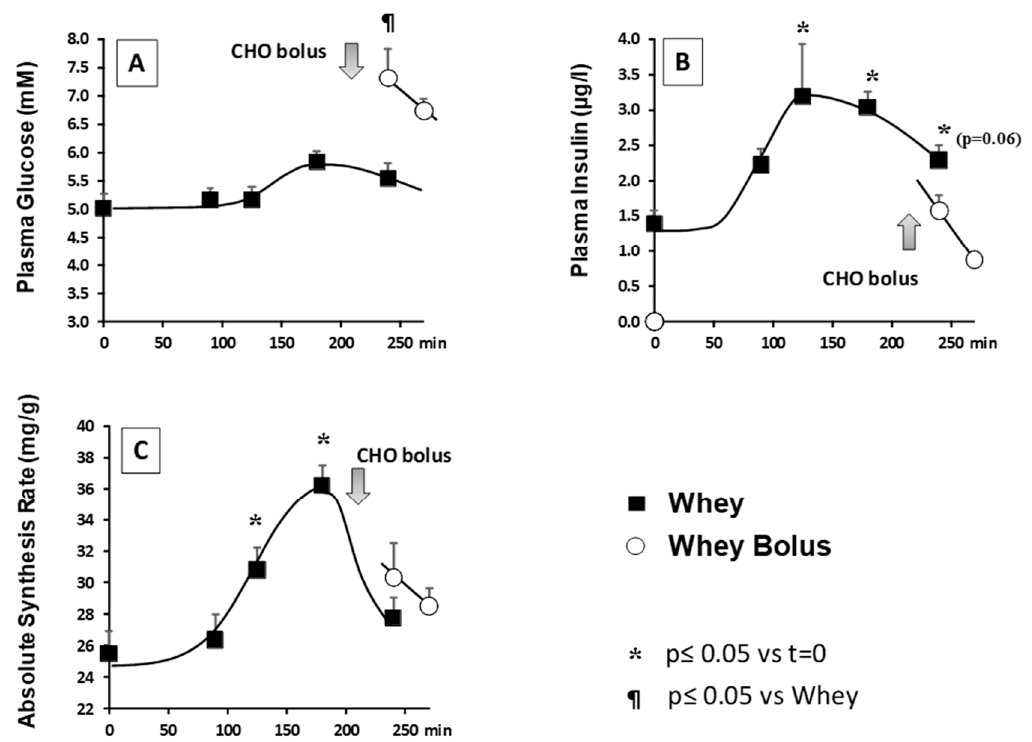
Figure 2. Plasma glucose ( A ), insulin ( B ) and muscle protein synthesis ( C ) in aged rats fed with whey or with whey followed by an energy bolus (CHO) 210 min after food intake. Data are presented as means ± SEM. ( n = 10).